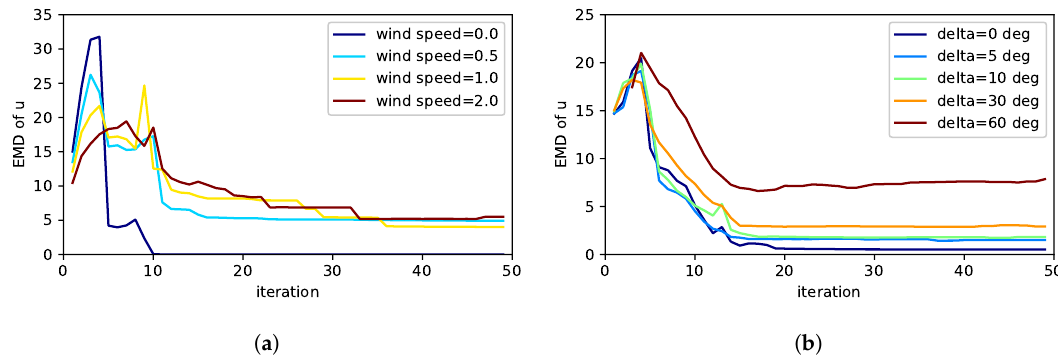
Figure 5. Analysis of a wrong wind prior on the performance of the exploration strategy measured by the EMD of the estimated source distribution: In ( a ) the exploration strategy was informed by the wind prior that there is no wind. The different curves show the performance for different simulated wind speeds contradicting the wind prior. Similarly ( b ) depicts the case, when the assumption about the wind speed encoded in the wind prior of the exploration strategy coincides with the simulation, but the wind direction differs between the actual simulation and the prior assumption. For the sparsity prior, relaxation parameter and measurement noise we have chosen the best values found in the previous section.